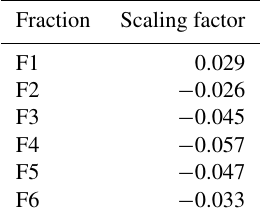
Table 3. Temporal pattern scaling factors for each of the